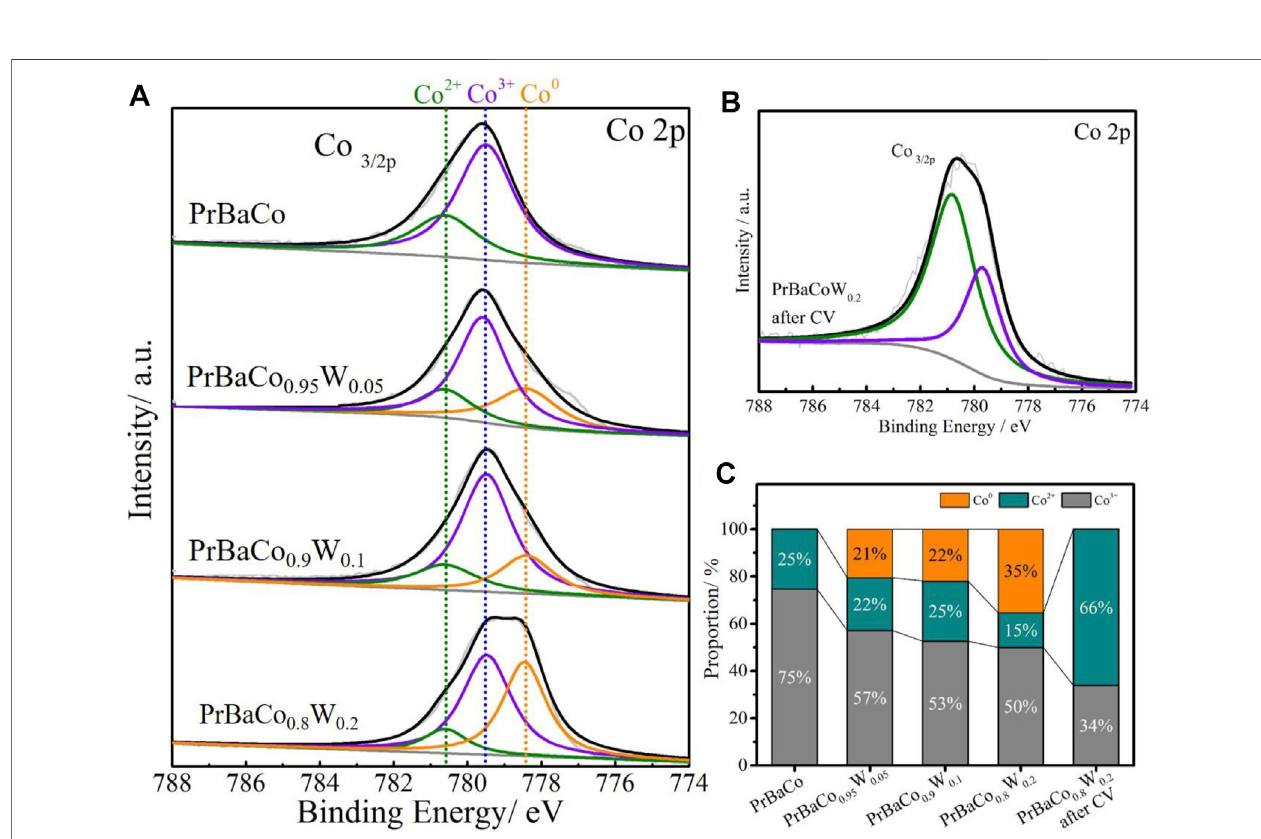
FIGURE3|(A) XPSspectra(Co2p)ofPrBaCo,PrBaCo 0.95 W 0.05 ,PrBaCo 0.9 W 0.1 andPrBaCo 0.8 W 0.2 . (B) XPSspectra(Co2p)ofPrBaCo 0.8 W 0.2 afterCVtest. (C) Co species proportion map of different samples.